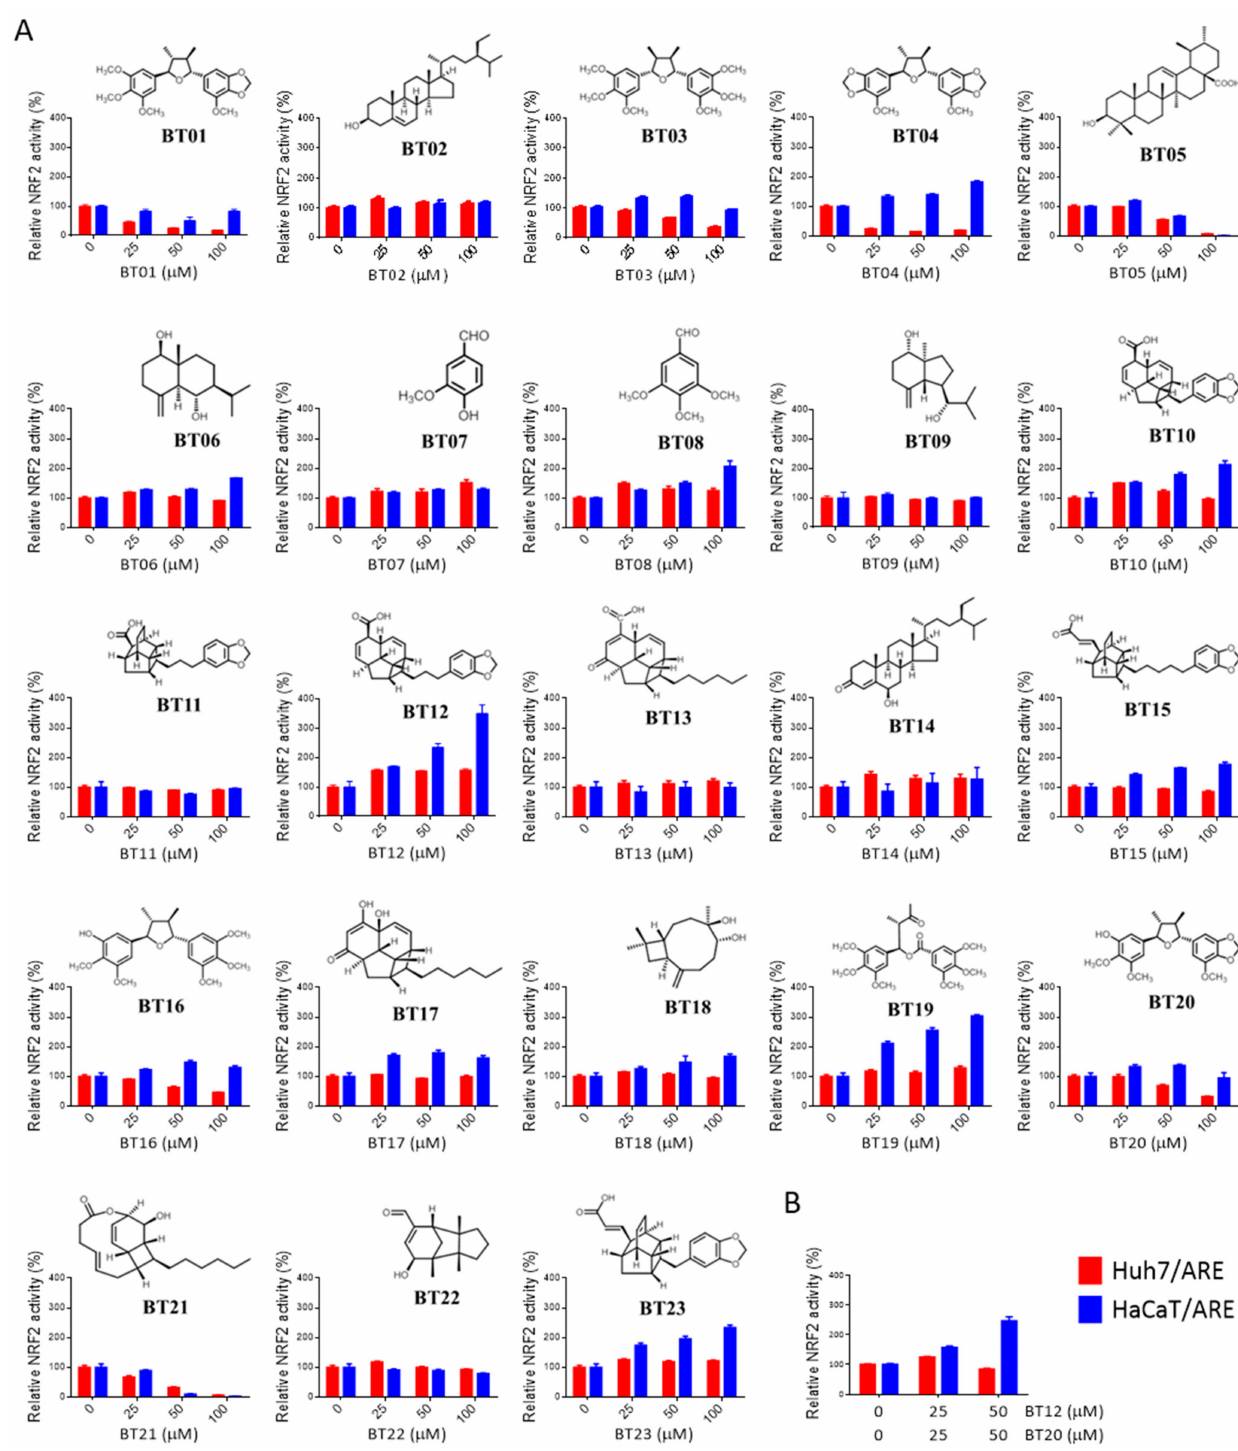
Figure 3. Potential active ingredients in BT extracts. ( A ) Concentration-response plots of compounds isolated from B. tsangii . The Huh7/ARE and HaCaT/ARE cells were treated with 23 compounds isolated from B. tsangii at 25, 50, and 100 µ M for 24 h. The relative NRF2 activity was determined as described in Figure 1D. Data are presented as mean ± SD, n =3. The compound names are listed in Supplementary Table S1. ( B ) Combinatory effects of BT12 and BT20 on NRF2 activity in Huh7 and HaCaT cells. The Huh7/ARE and HaCaT/ARE cells were treated with BT12 and BT20 at 25 and 50 µ M for 24 h. Then, the relative NRF2 activity was